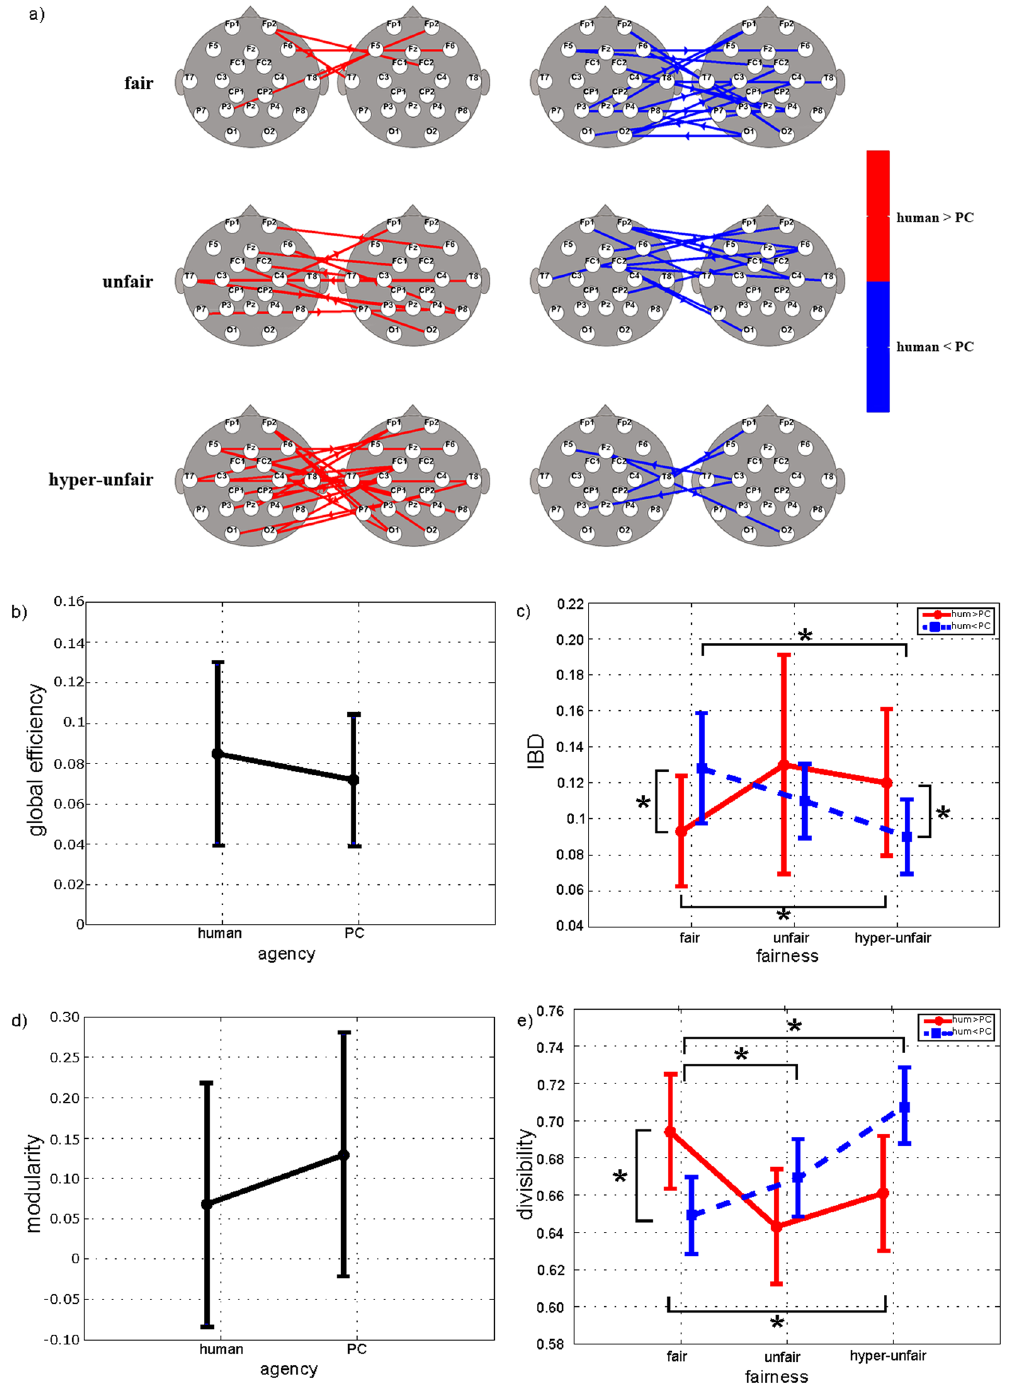
Figure 5. ( a ) Statistical interbrain connectivity patterns in alpha band. Statistical interbrain connectivity patterns comparing human vs PC conditions in the alpha band (group analysis, paired t-test; p < 0.05 FDR-corrected). The patterns were reconstructed for the three fairness levels separately. Red arrows are for human > PC, and blue arrows are for human < PC. b,c,d,e) Results of two-way ANOVA on global efficiency (p = 0.032, F(1,14) = 5.64) (panel b), interbrain density (p = 0.0095, F(2,28) = 5.52) (IBD - panel c), modularity (p = 0.006, F(1,14) = 10.47) (panel d), and divisibility (p = 0.0062, F(2,28) = 6.13) (panel e) computed for connectivity networks in alpha band. * Indicates statistical differences as confirmed by Neumann-Keuls post hoc test (p <